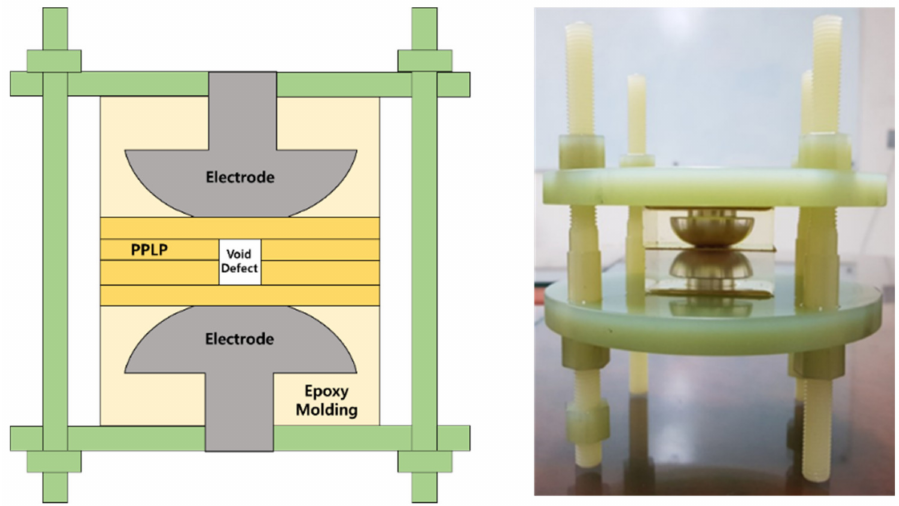
Figure 2. Structure of MI-PPLP specimen and test